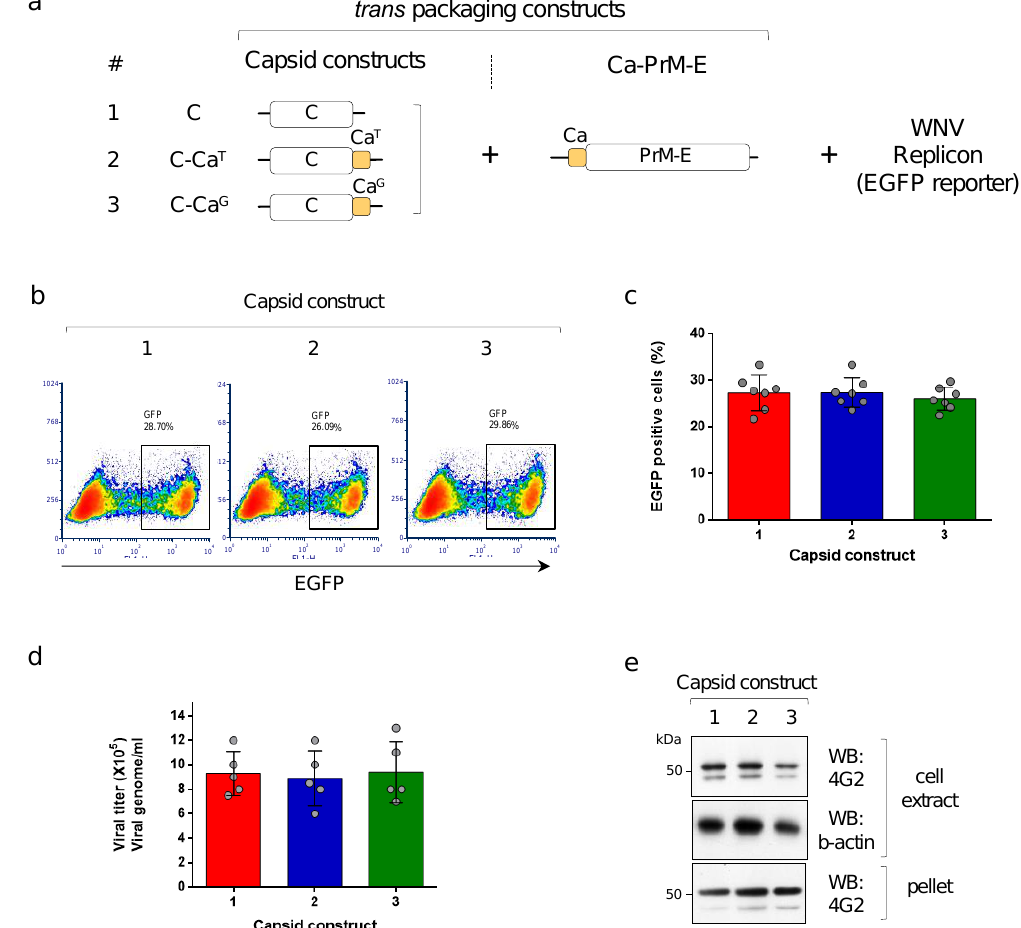
Figure 1. ( a ) Scheme of the tripartite system to produce pseudoviruses, showing the trans-packaging constructs encoding C or C-Ca (numbered 1–3) and the Ca-PrME and the WNV replicon (with EGFP reporter). ( b ) Representative cytofluorimetry (EGFP) of VERO cells infected with the pseudoviruses produced with the indicated capsid constructs. ( c ) Quantification of data shown in ( b ) ( N = 7). ( d ) Quantification of viral genomes packaged in the indicated pseudovirus preparations ( N = 5) ( e ) Western blot of cell extracts and pellet supernatants of cells producing the indicated pseudoviruses, developed with mAb 4G2 (anti-E). β -actin was used as the loading control.